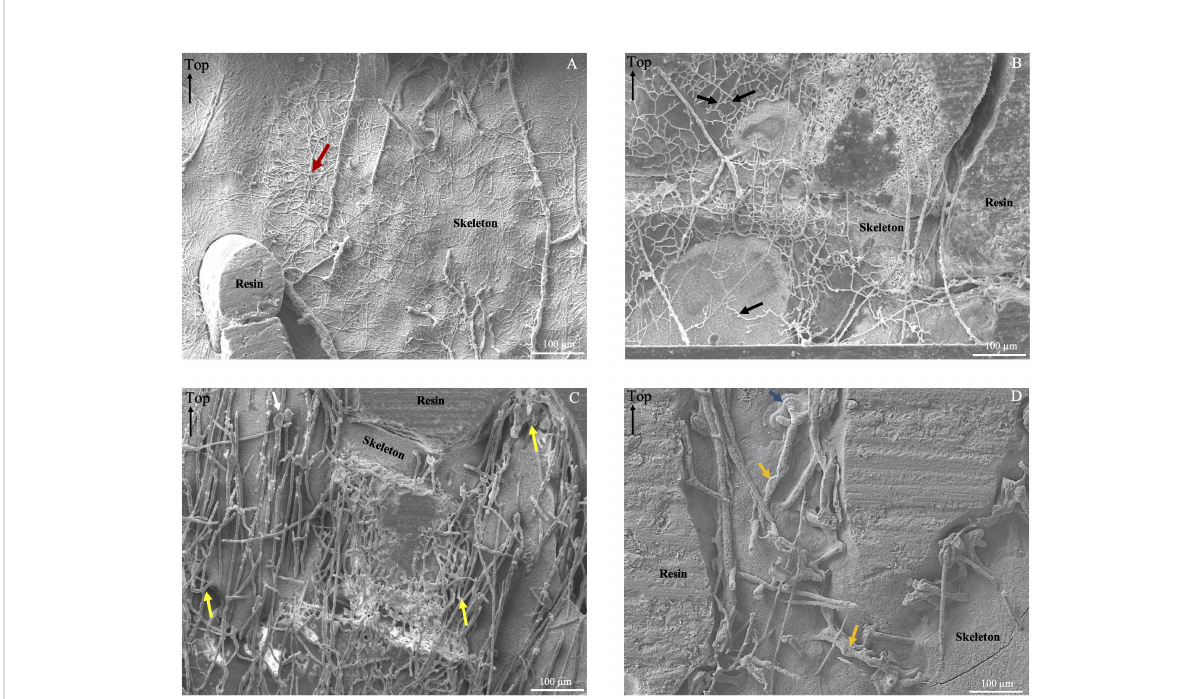
FIGURE 6 SEM pictures presenting the diversity of traces (microborings) observed along the coral core. (A) SEM image from the top of the core showing traces of Scolecia fi losa (produced by the cyanobacterium Plectonema sp.; red arrow). (B) Picture from the bottom of the core showing a great abundance of the typical Ichnoreticulina elegans trace (work of the chlorophyte Ostreobium sp. quekettii .; black arrows). (C) Picture from the bottom of the core showing wide microborings oriented towards the coral tissue layer. Tubules presenting branches (yellow arrow) and club shape apexes (white arrow) indicative of microboring algae. In the center of the picture, traces of Ichnoreticulina elegans can be observed. (D) Picture from the middle of the core showing very wide microborings (> 20 µm) oriented towards the coral tissue layer. Those traces are cylindrical tubules, sometimes with bulges and visible cross-wall constrictions (yellow arrows), as well as branches (blue